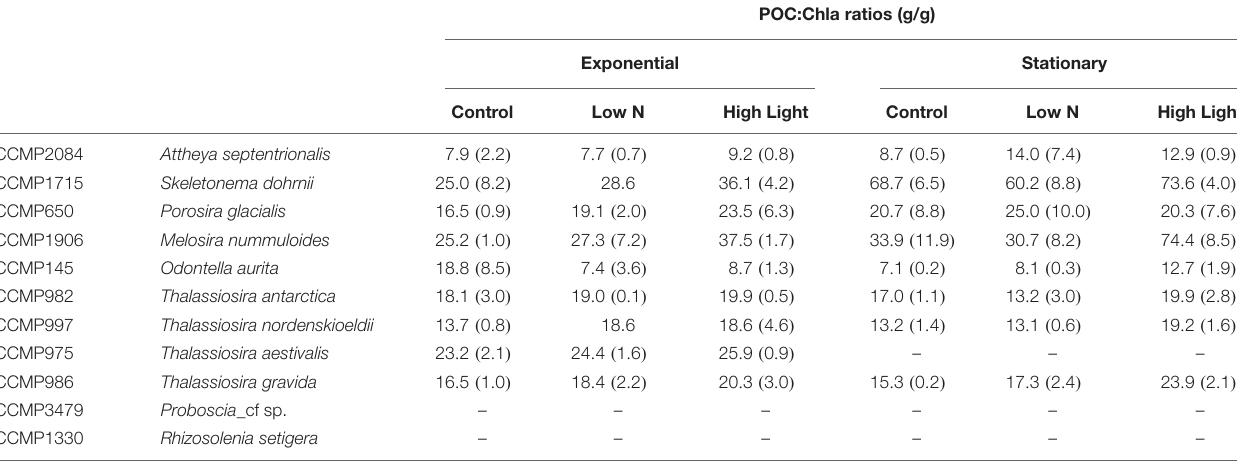
TABLE 5 | Ratios of POC:Chla (g:g) for each culture, experimental treatment, and growth phase.